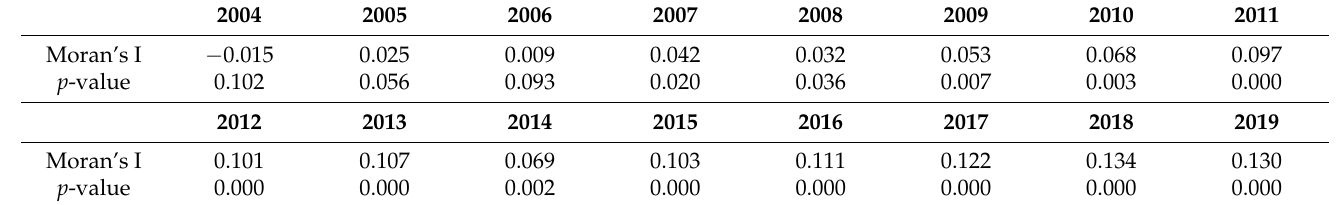
China, 2004–2019.